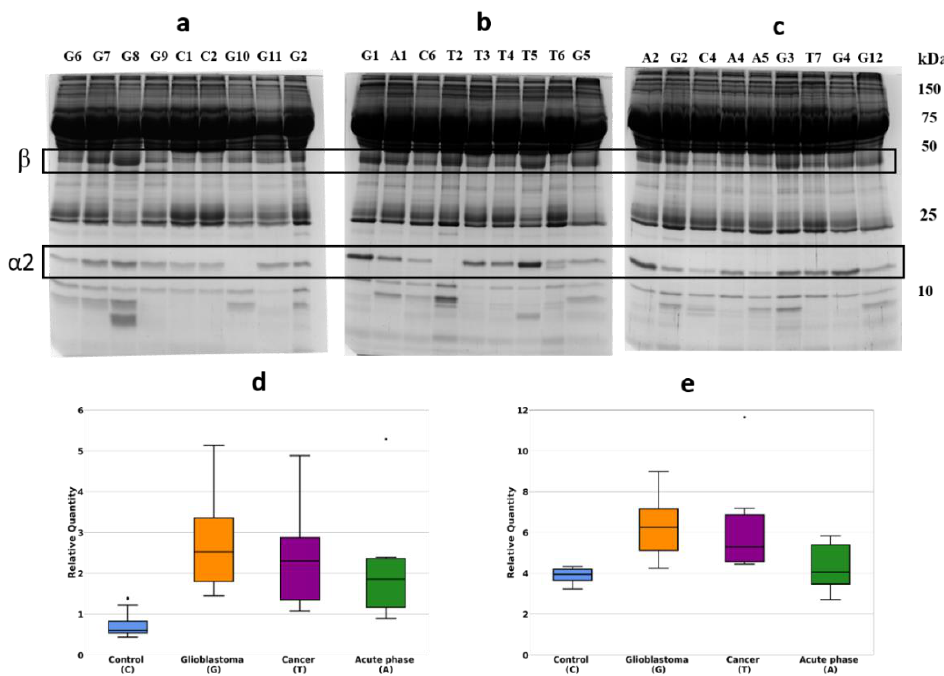
Figure 1. SDS-PAGE of plasma samples, Coomassie staining. The representative gels stained with Coomassie ( a – c ). Statistical analysis of the band intensity of α 2-chain ( d ). Statistical analysis of the band intensity of β -chain ( e ). GBM samples are marked as G, control—as C, cancer—as T, acute phase—as A.